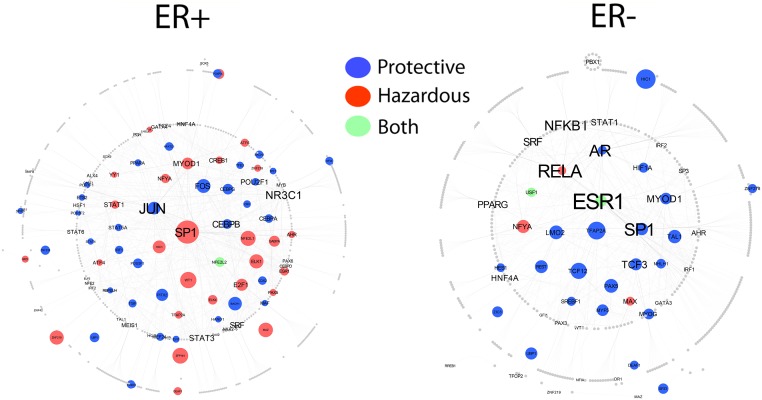
PPI network for TFs with binding motifs enriched in ER+ and ER- breast cancer.Only TFs with TF binding motifs enriched (depleted TF binding motifs excluded) with P<0.05 were included in the networks. Node circumference is scaled according to mean P-value of TF binding motifs of TFs. Larger nodes correspond to lower P-values. Text size is mapped to node degree where larger text font scales with higher node degree. Node color corresponds to the CpG category TF binding motifs are enriched in. Blue nodes indicate TFs with motifs enriched in protective CpG regions, red nodes indicate TFs with binding motifs enriched in hazardous CpG regions, and green nodes correspond to TFs with binding motifs enriched in both hazardous and protective CpG regions. Grey nodes are first-degree protein partners that interact with TFs whose motifs were identified as enriched in survival-associated CpG regions.